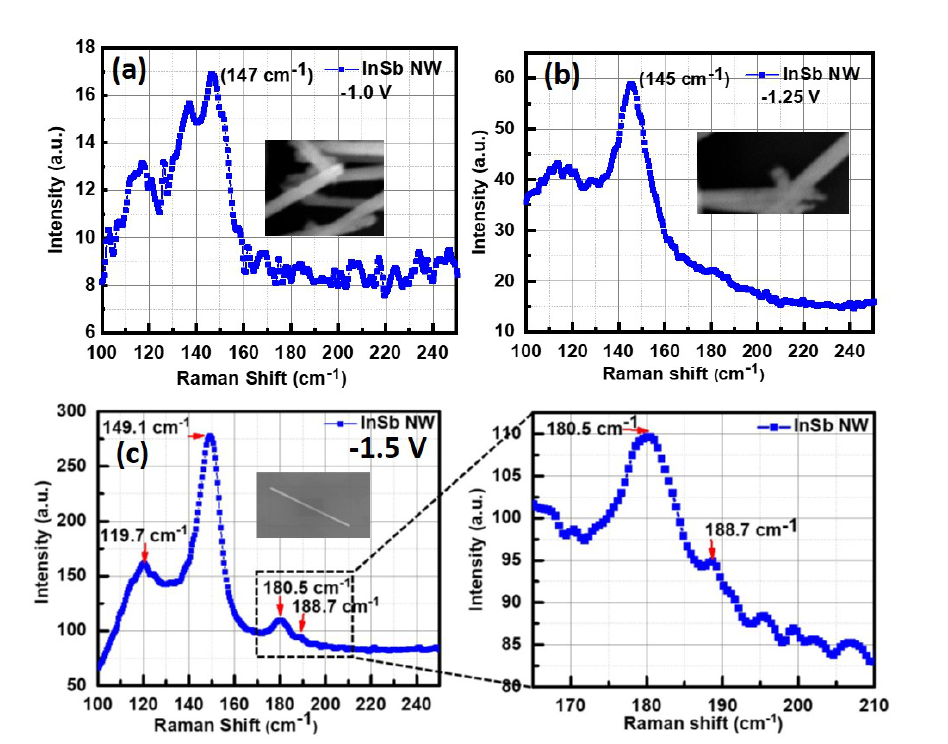
∼ 5 µ m) InSb nanowire that is shown in